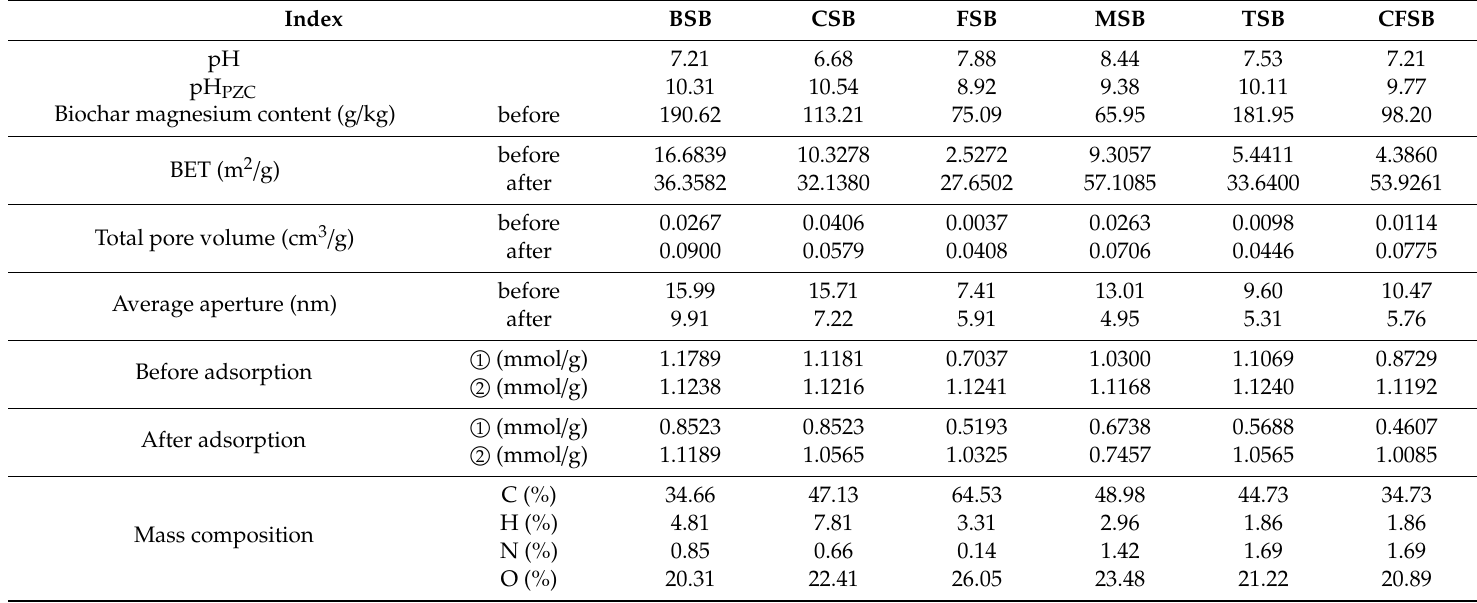
Table 1. Basic characteristics of the biochars from six di ff erent raw